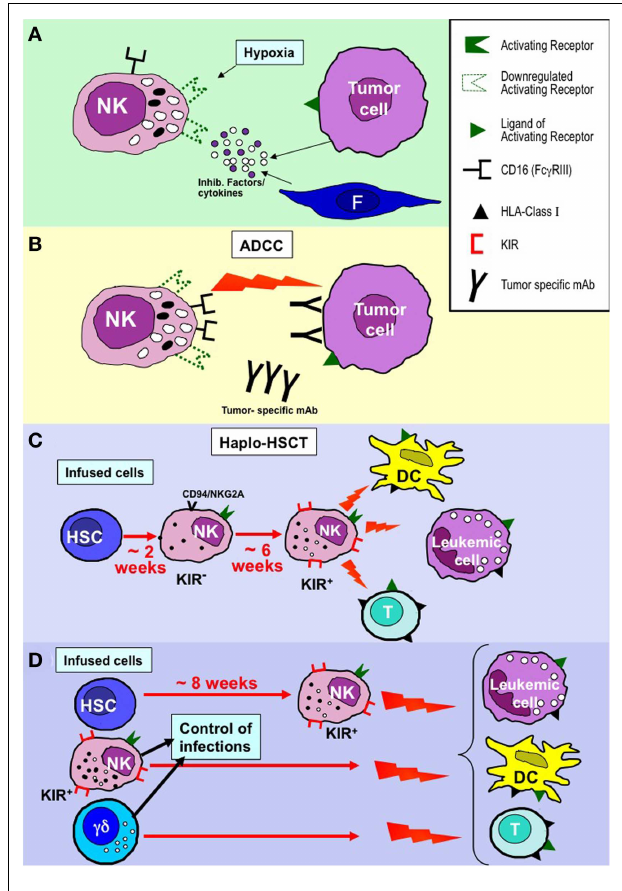
FIGURE 1 | NK cell-based approaches in the immunotherapy of tumors and leukemias . (A) NK cell function may be greatly hampered by inhibitory factors and/or cytokines produced by tumor cells or cells of the tumor microenvironment (e.g., fibroblasts, F) and by hypoxia that primarily induce down-regulation of activating NK receptors. (B) CD16-mediated antibody dependent cytotoxicity (ADCC) appears to be poorly susceptible to the inhibitory tumor microenvironment.This mechanism may contribute to the positive clinical outcome of patients treated with tumor-specific monoclonal antibodies (mAbs). (C) In theT-depleted haplo-HSCT, KIR + alloreactive NK cells derived from donor HSC (generated after 6–8weeks) kill leukemia blasts (inducing GvL), DC (preventing GvHD), andT cells (preventing graft rejection) remaining after the conditioning regimen. (D) In haplo-HSCT, early leukemia relapses and severe viral infection may occur during the time interval (6–8weeks) required for the generation of efficient alloreactive NK cells.The novel approach based onTCR α / β + - and B cell-depletion allows the infusion of donor-derived mature alloreactive NK cells andTCR γ / δ + cells together with HSC, thus allowing a better control of leukemia relapses, GvHD, graft rejection, and viral